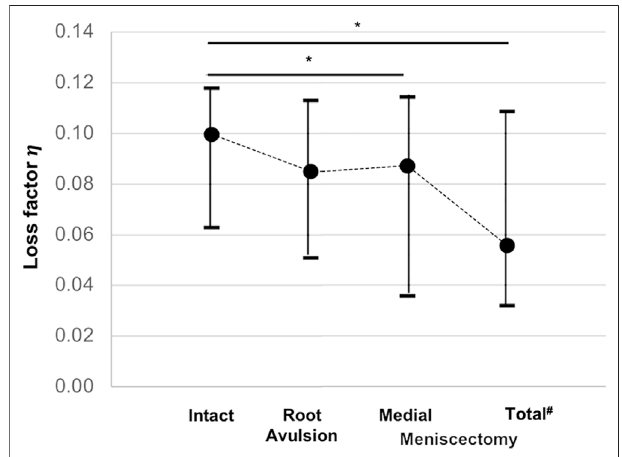
FIGURE 6 | Minimum, median, and maximum loss factor ( η ) values compared at the four investigated meniscus states: intact, root avulsion at the posterior horn of the medial meniscus, medial meniscectomy and total lateral and medial meniscectomy. The dotted line indicates the progression of the consecutively investigated meniscus states. # The total meniscectomy state was statistically lower than any of the other states; *Wilcoxon test: *,# p < 0.05; n =